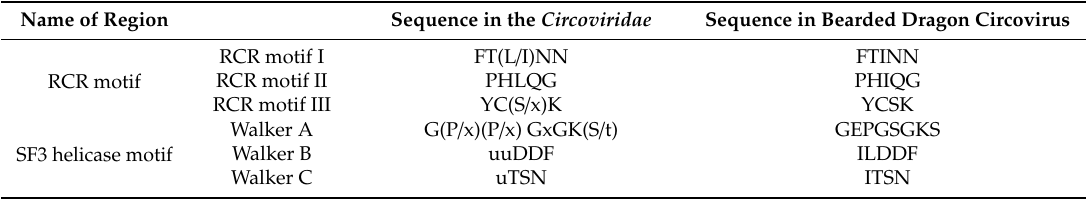
Table 2. Rep protein (amino acid) motifs detected in the bearded dragon